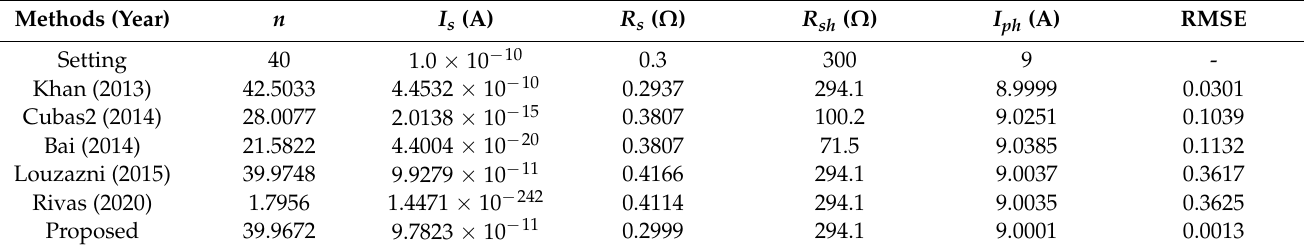
Table 1. Parameter-extraction results and RMSE for I- and P-V Curves in Figures 3 and 4 at G = 1000 W/m 2 and T = 25 ◦ C. Methods (Year)